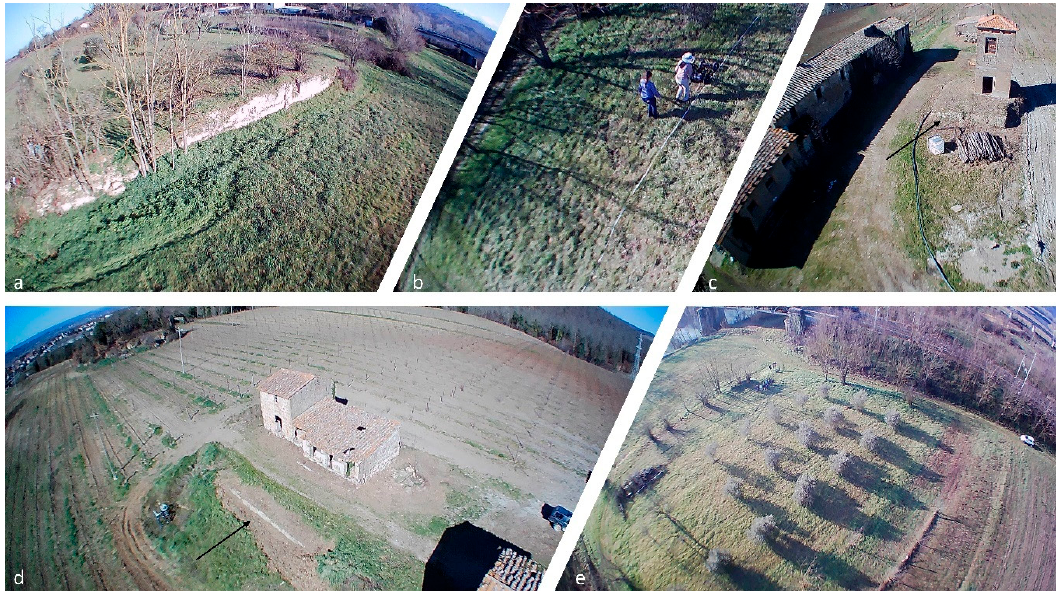
Figure 4. Drone-borne imagery. ( a ) The wall and the olive grove (San Valentino). ( b ) The parch marks on which the grass is less green (San Valentino). ( c ) The opus caementicium foundation of the electrical tower can be seen (Malvicino). ( d ) The retaining wall/cistern in front of the pigsty (Malvicino). ( e ) On the right side, the dispersion of the ancient sherds can be seen, which are particularly visible due to the reddish color of the superficial soil (San Valentino).